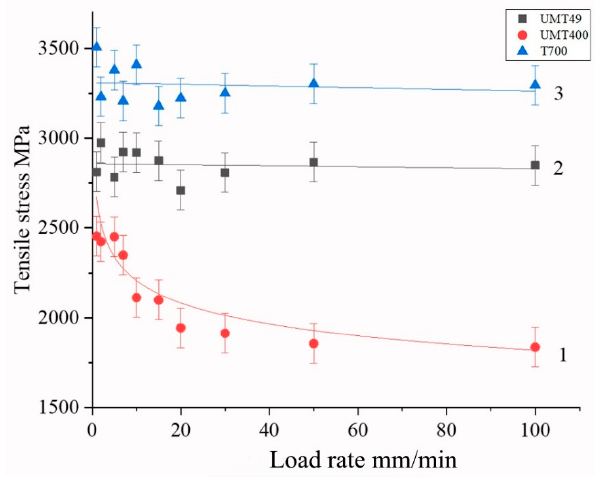
Figure 5. Dependences of tensile strength on the loading rate for composites containing 30 wt. % of polysulfone.